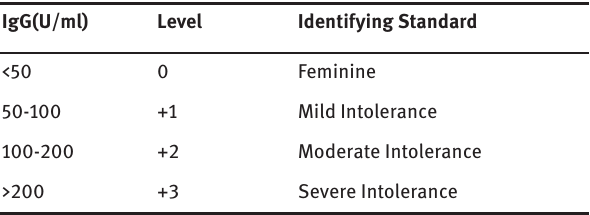
Table 1: Identifying standard of food intolerance.